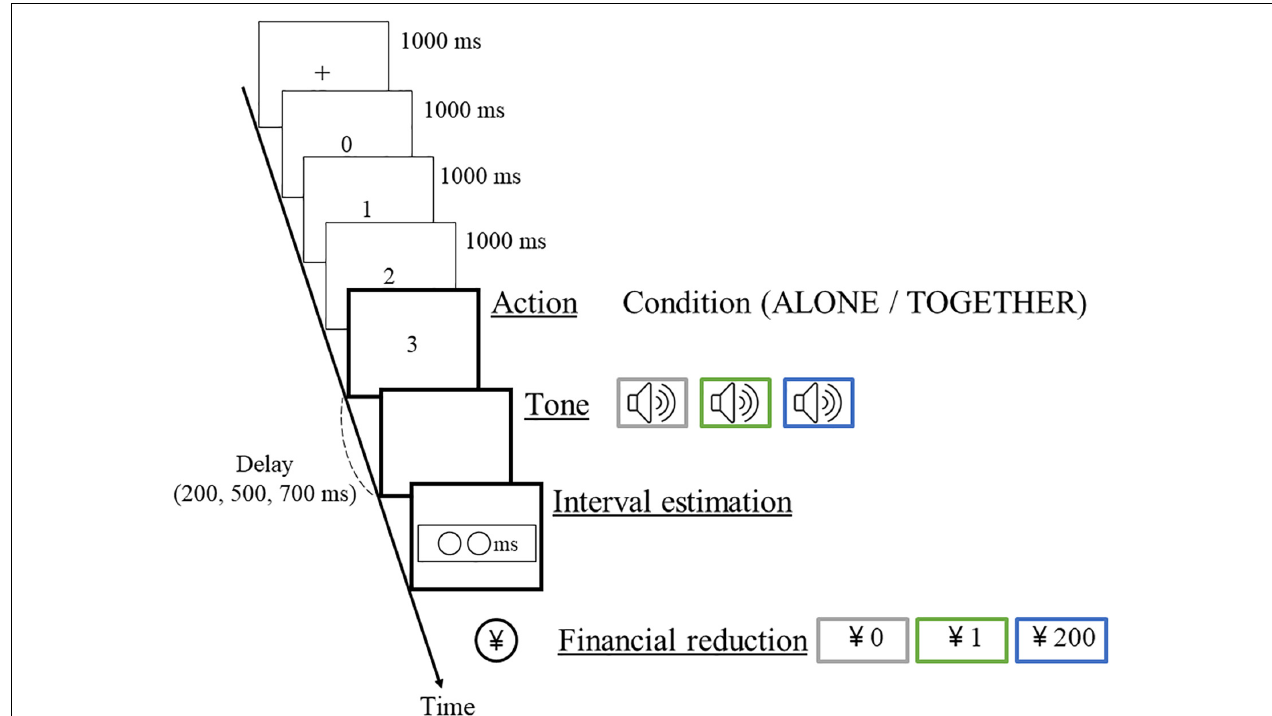
FIGURE 1 | Experimental paradigm. The ALONE condition required the key to be pressed by the participant alone; the TOGETHER condition required the key to be pressed simultaneously with the experimenter. After a black cross was presented on screen for 1 s, the number was counted every 1 s, and when the number displayed 3, participants were instructed to press the key. Participants estimated the time intervals and answered the values using a keyboard. The financial reduction value was associated with each pitch. The financial reduction consisted of three conditions: the Baseline condition, the Low-harm condition, and the High-harm condition. When the pitch of the Low-harm condition or the High-harm condition sounded, participants actually performed the procedure to reduce the amount of money after estimating the time